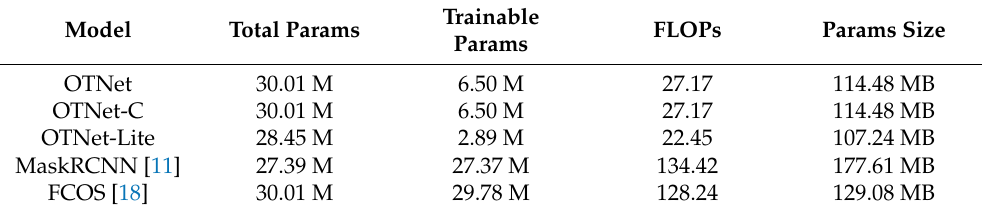
Table 2. The computation complexity results. Model Total Params